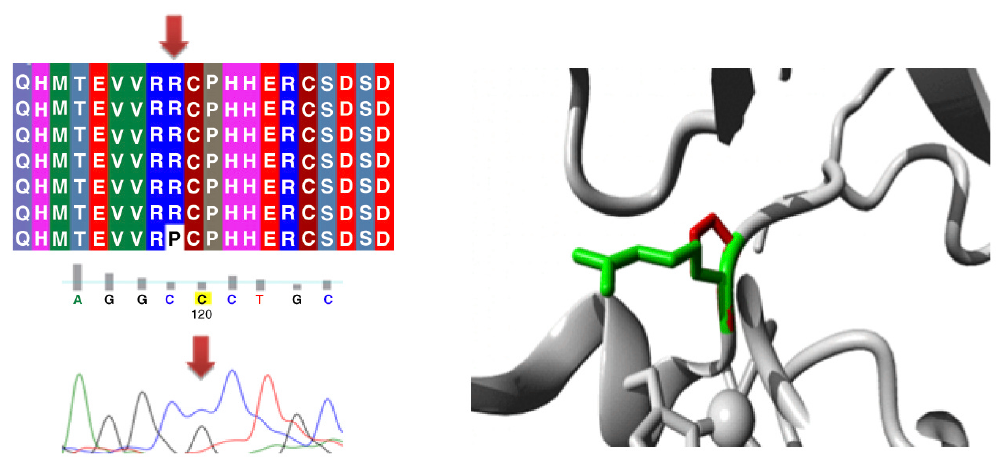
Figure 5. Mutation of arginine into proline at position